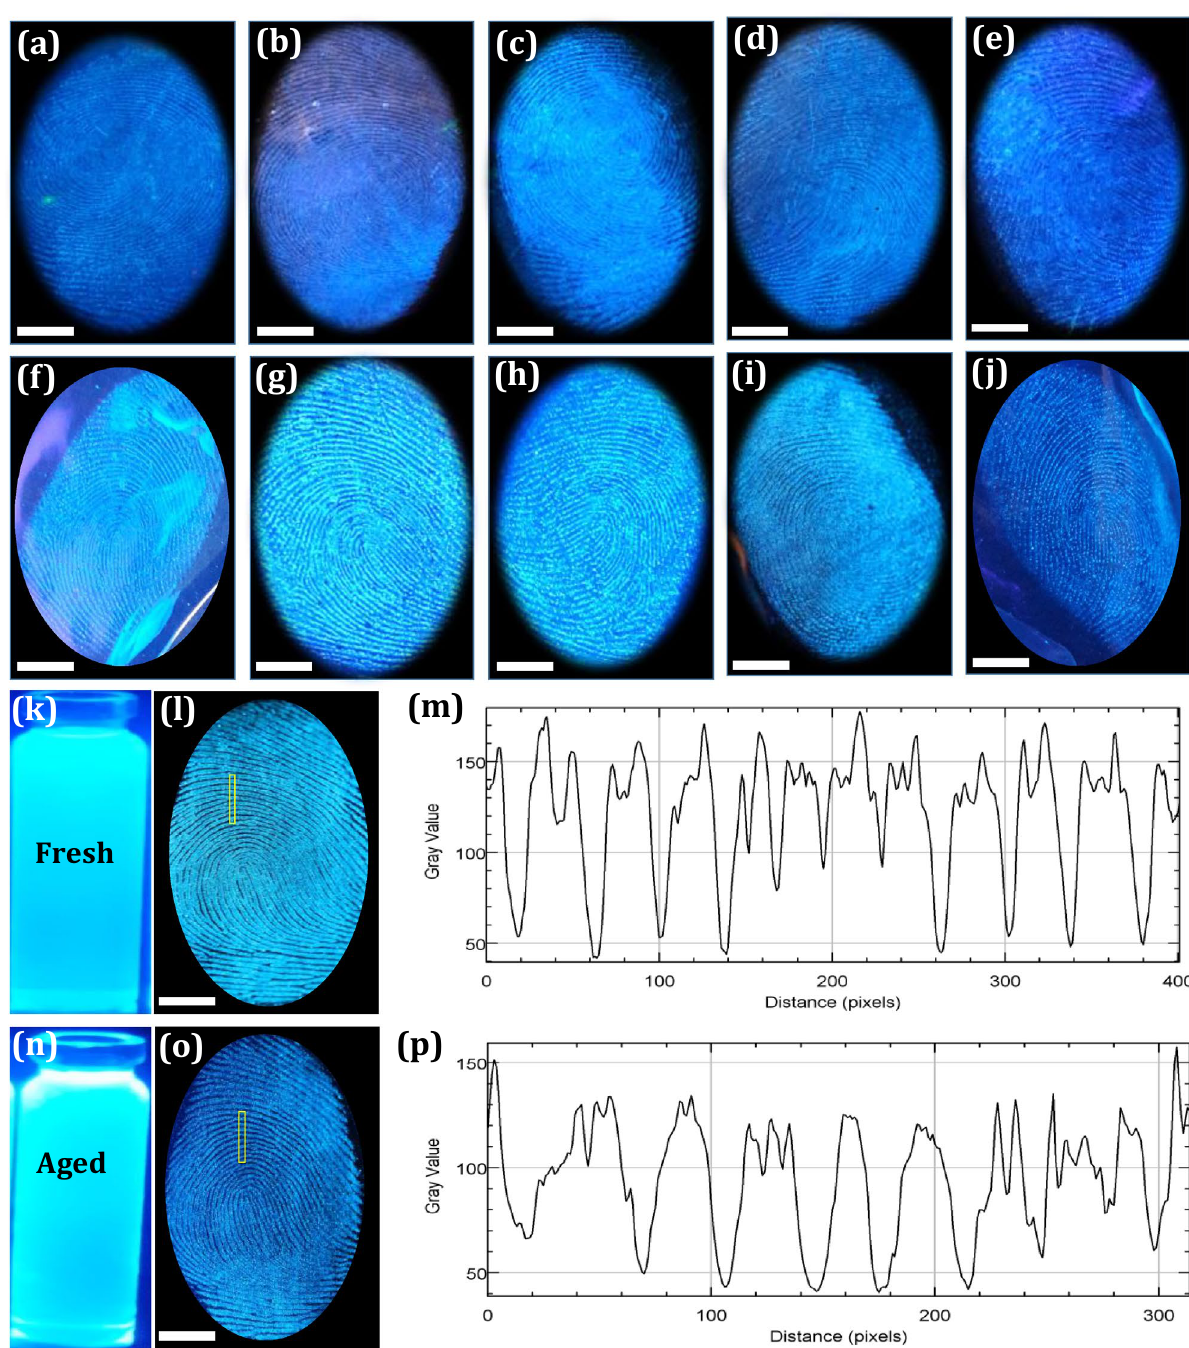
Figure 3. ( a–j ) FPs images developed using various binary mixture concentrations (Ethanol–water fraction) of prepared FDIP molecule on glass surface upon UV 365 nm light illumination; ( k,l,n,o ) Fresh and aged FDIP solution after storing for 3 months and used for LFPs development on glass surface; ( m,p ) Gray scale profiles of the corresponding images of ( l,o ) (Scale bar: 5